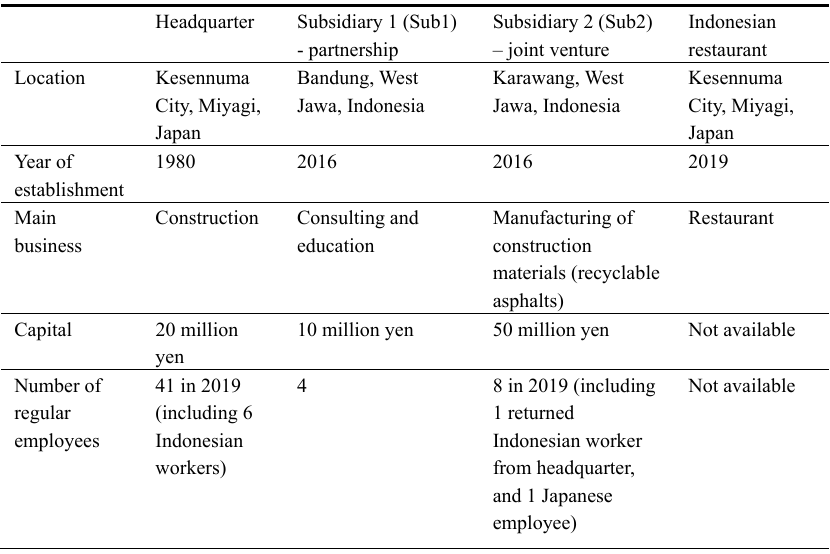
Table 2. Case profile of